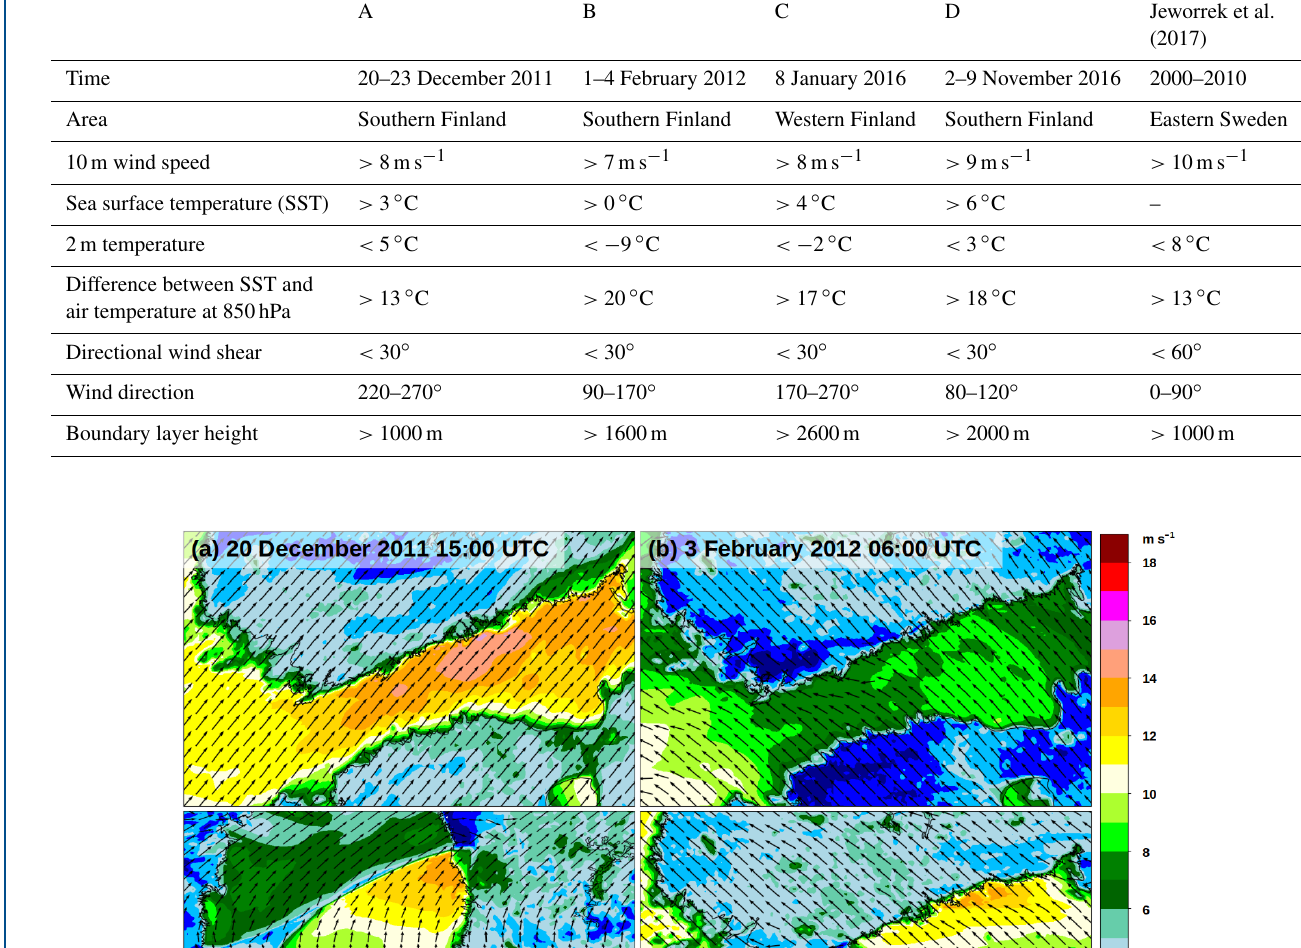
Table A1. The minimum atmospheric conditions fulfilled over the Baltic Sea within the four selected sea-effect snowfall cases (A–D) based on HARMONIE simulations. In addition, the thresholds defined in Jeworrek et al. (2017) are shown. A B C D